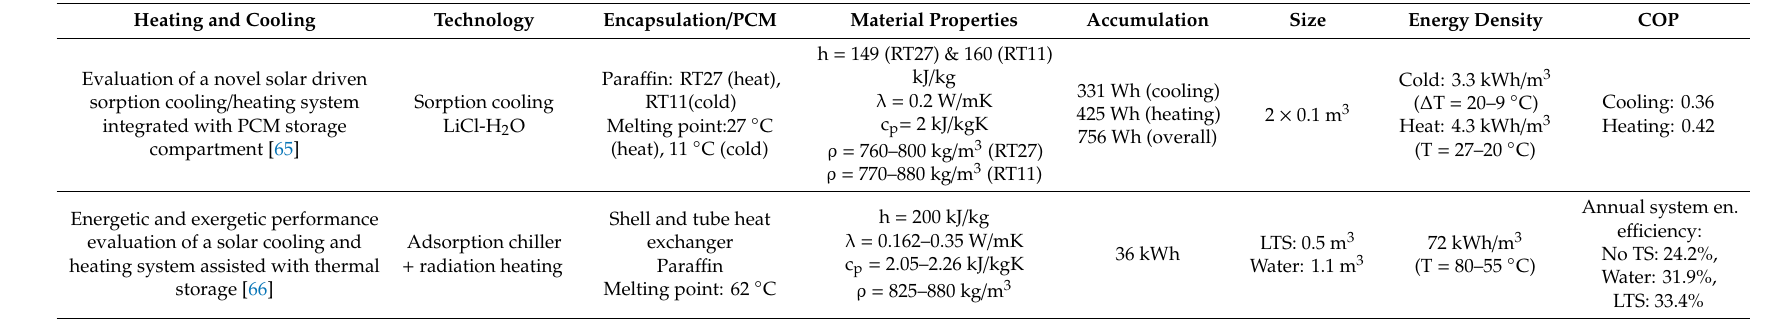
Table 3. Overview of heating and cooling technologies with